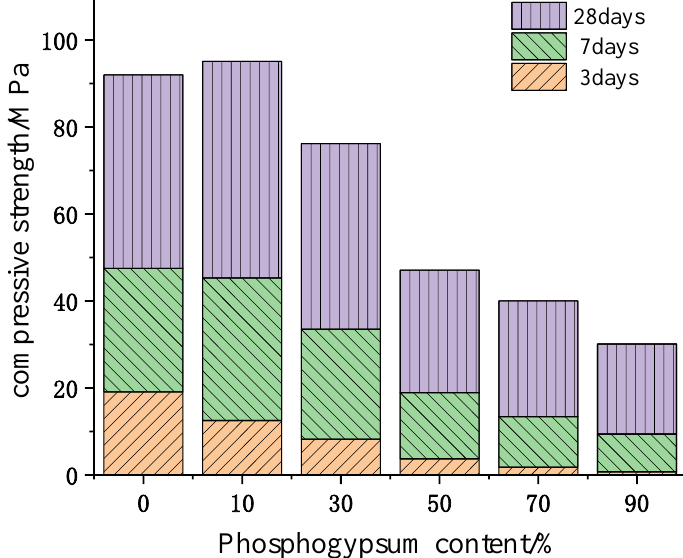
Figure 9. Flexural strength of composite cementitious material.